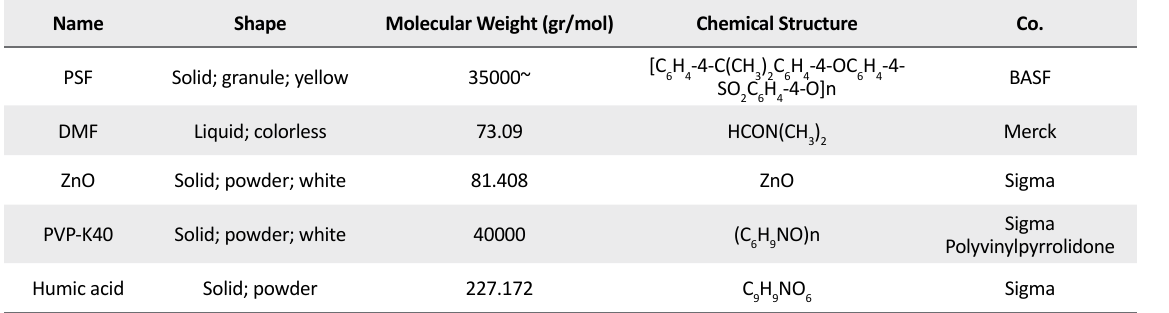
Table 1. The characteristics of the materials used in this study Name Shape